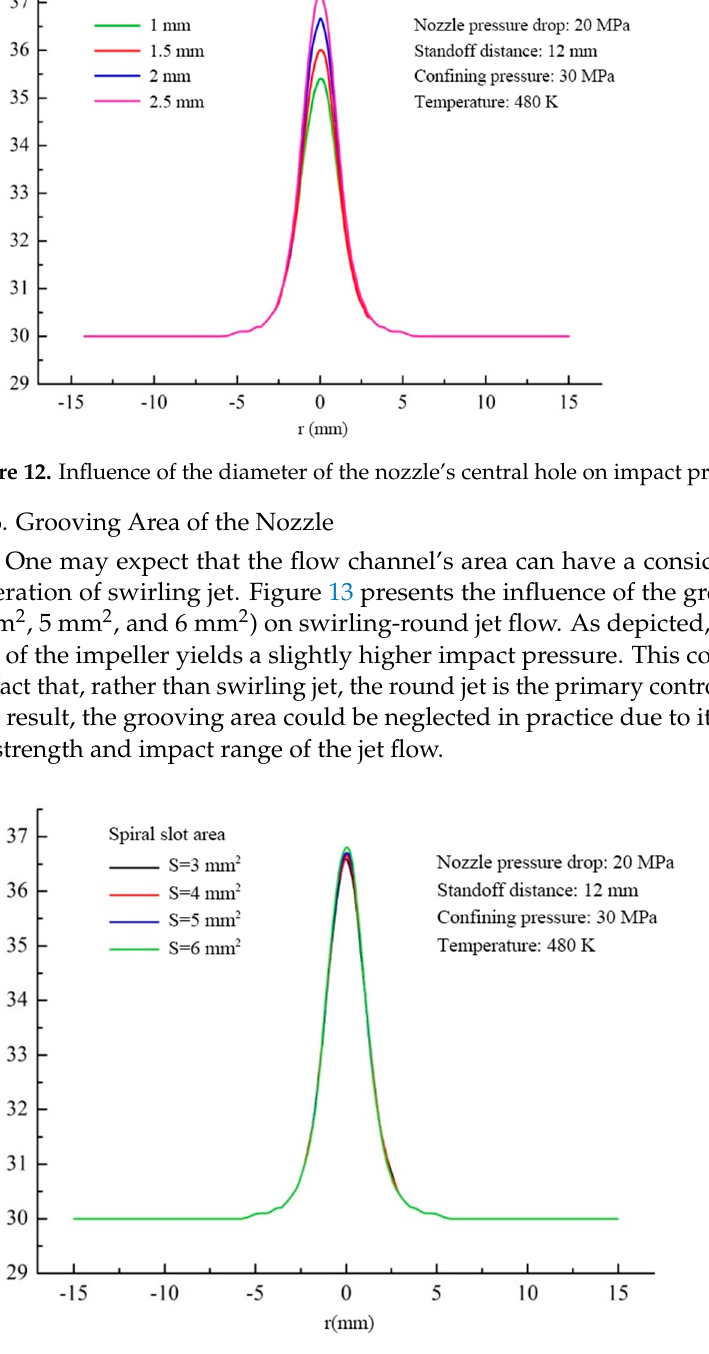
Figure 11. Influence of jetting distance on impact pressure.